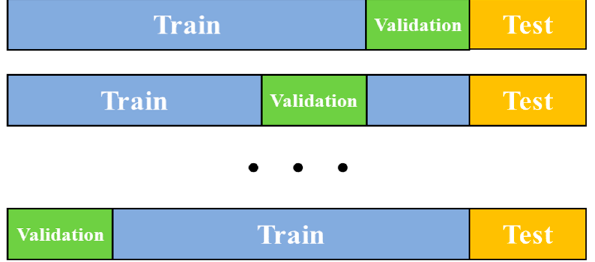
Figure 10. Cross-validated data grouping.